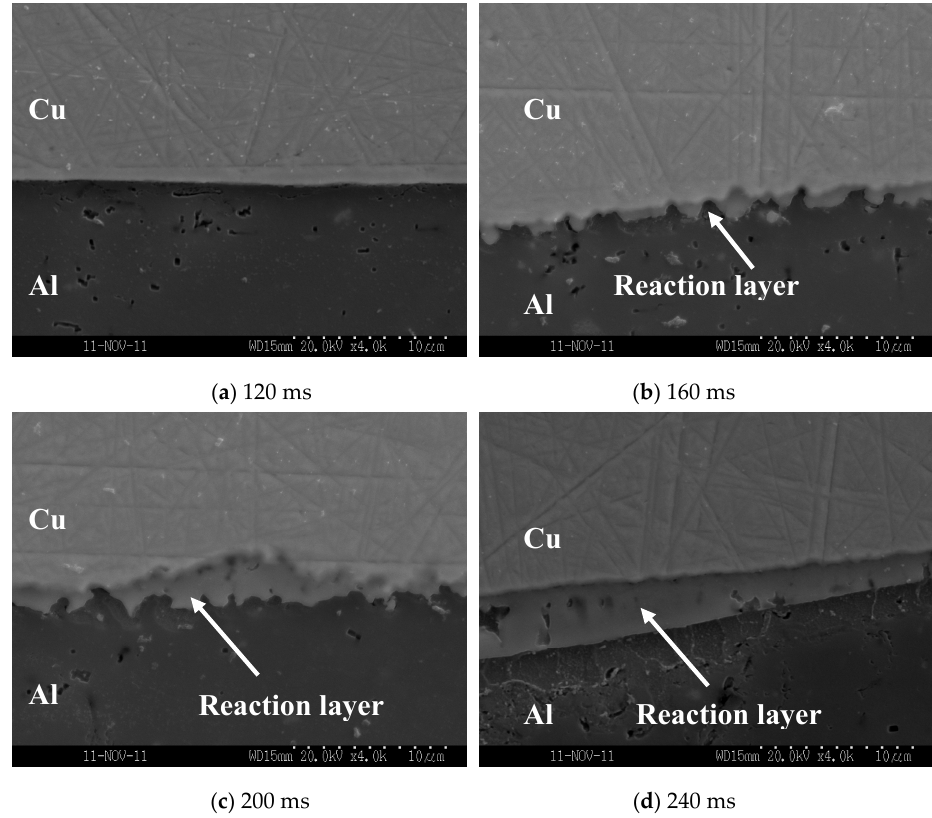
Figure 3. Scanning electron microscopy (SEM) images of the cross-section of the joints welded with different welding duration, which show a growth trend of the reaction layer.